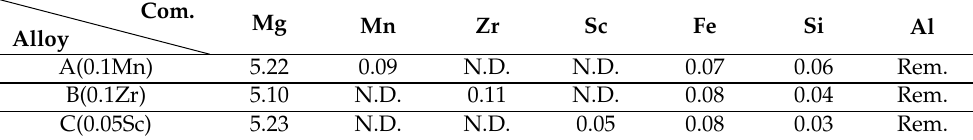
Table 1. Analysis of alloy composition (wt%).